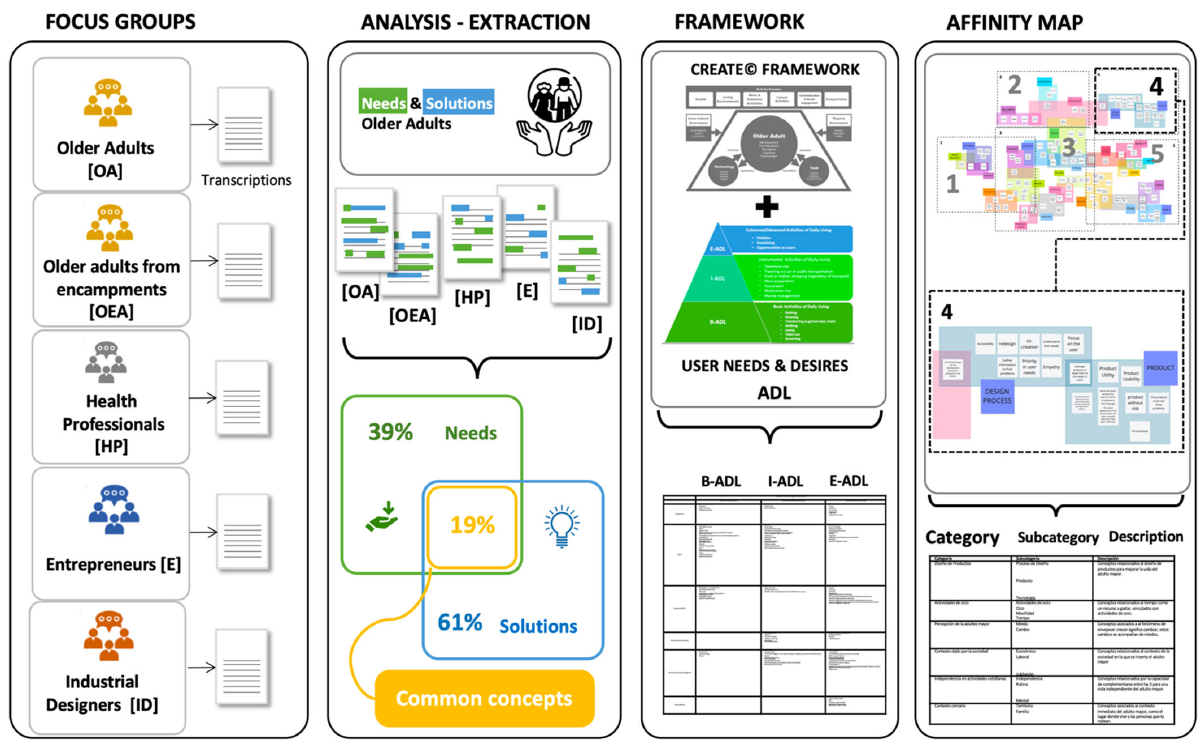
Figure 2. Methodological sequence addressed in the study. Source: developed by the